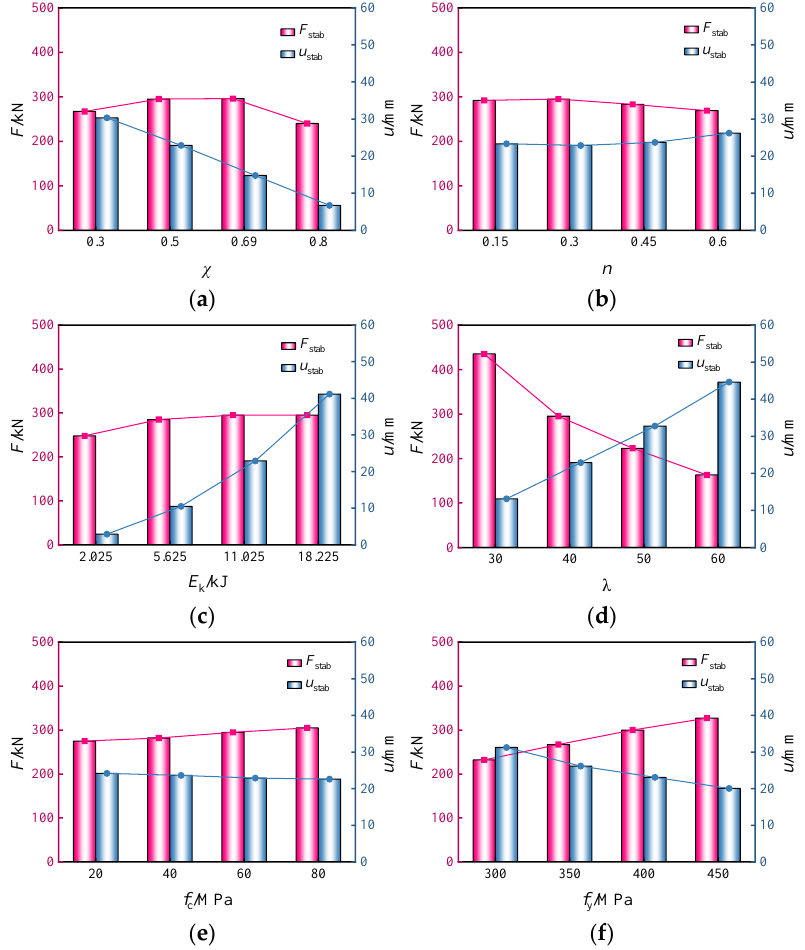
Figure 7. Dynamic responses of the CFDST columns. ( a ) Hollow ratio. ( b ) Axial compression ratio. ( c ) Impact energy. ( d ) Slenderness ratio. ( e ) Concrete strength. ( f ) Steel strength.